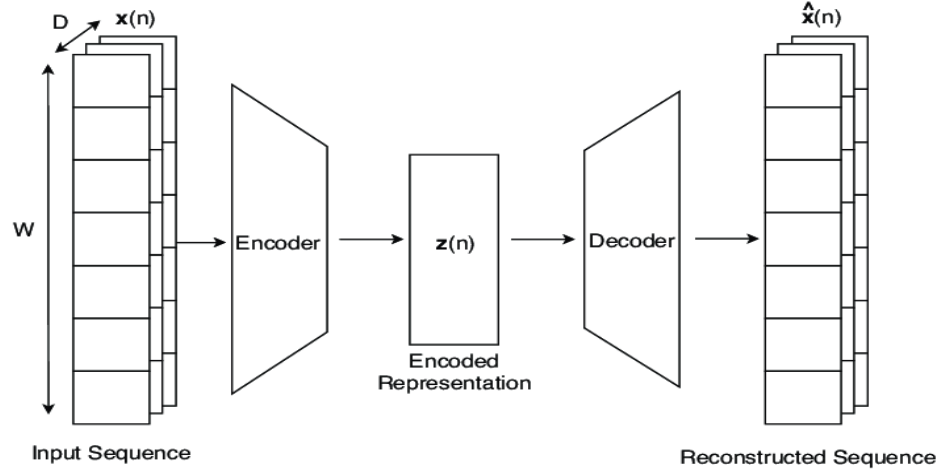
Figure 6. The LSTM-based autoencoder